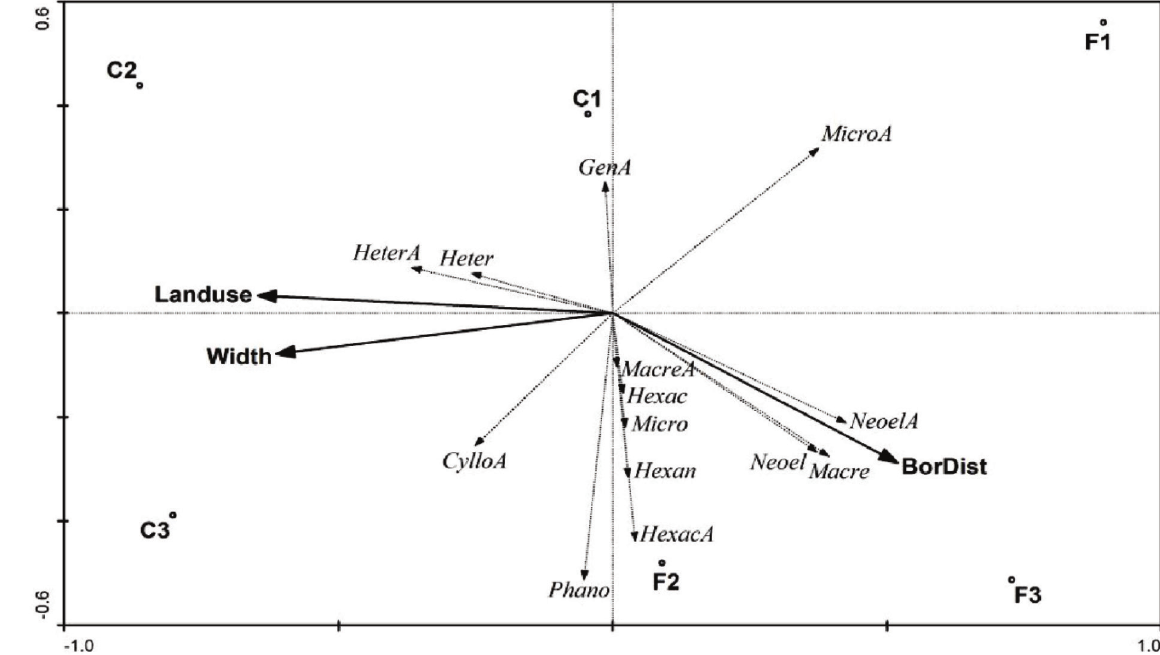
Figure 3 - Ordination diagram of streams and riffle beetle genera assemblages of the Redundancy Analysis constrained by land use, distance from the forest edge, and stream width in Parque Estadual do Turvo. Taxa abbreviation: Cyllo: Cylloepus , Gen: Genus undetermined; Heter: Heterelmis , Hexac: Hexacylloepus , Hexan: Hexanchorus , Macre: Macrelmis ; Micro: Microcylloepus ; Neoel: Neoelmis ; Phano: Phanocerus ; letter A at the end of genus name refers to adult stage; and F1, F2, F3 and C1, C2, C3 refer to the streams studied in forested (F) and converted (C)